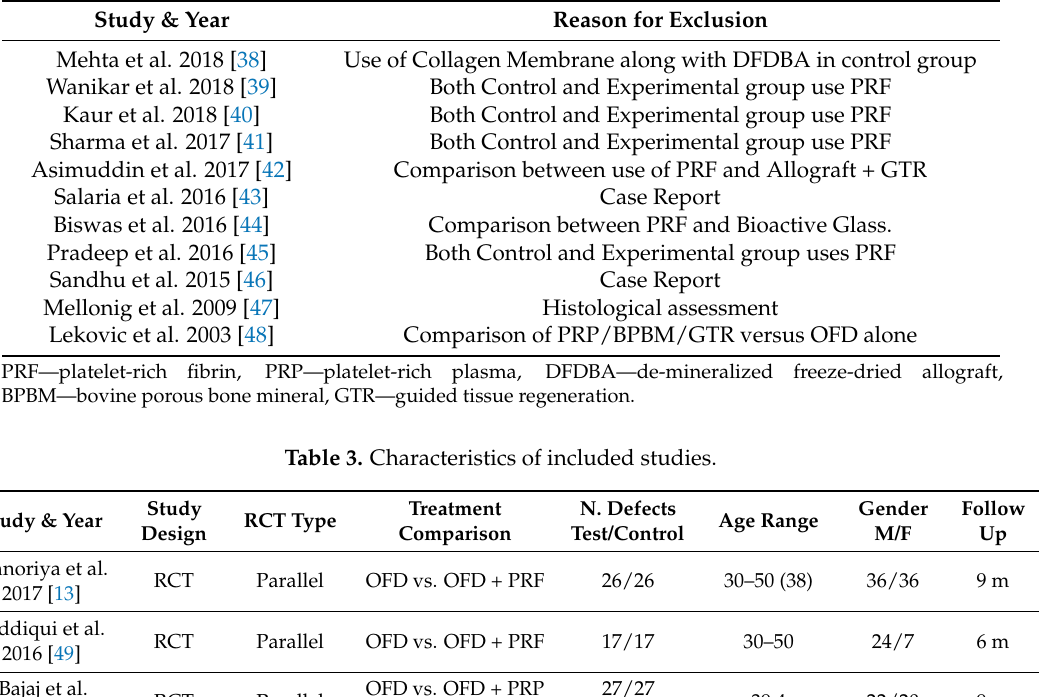
Figure 1. Flow chart depicting study selection process. Table 2. List of excluded studies.